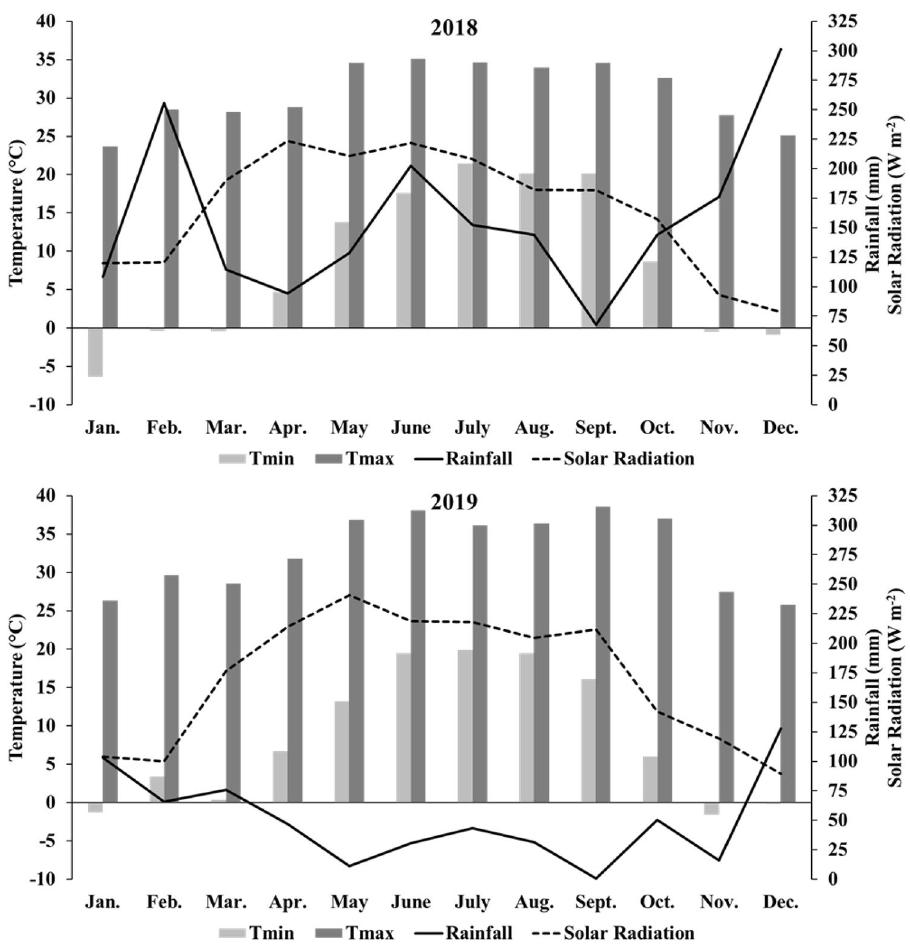
Figure 5. Monthly weather conditions at North Florida Research and Education Center (NFREC) Marianna, FL, during the experimental